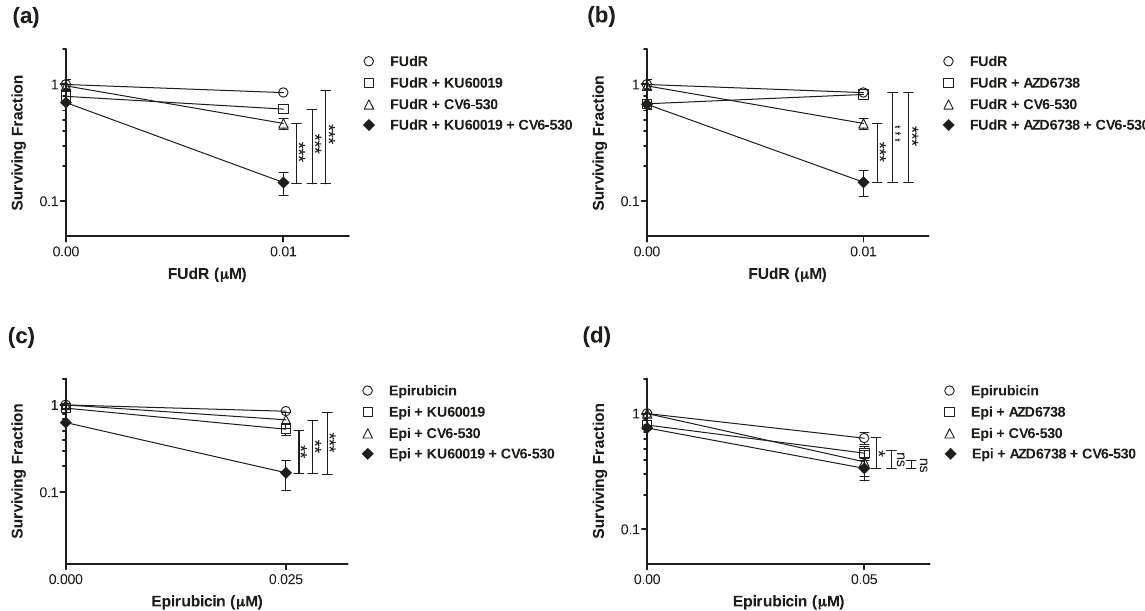
Fig. 4 Inhibition of dUTPase leads to replication stress and persistent DNA double-strand breaks following combination treatment with chemotherapy. Cell survival was determined by colony formation assay. MDA-MB-231 cells were seeded into 24-well plates and treated with ( a , b ) 0.01 µM FUdR alone or in combination with 12.5 µM CV6-530 and/or ( a ) 2.5 µM ATM inhibitor (KU-60019) or ( b ) 100 nM ATR inhibitor (AZD6738) or ( c , d ) 0.025 or 0.05 µM epirubicin (4 h) alone or in combination with 12.5 µM CV6-530 (24 h) and/or ( c ) 2.5 µM ATM inhibitor (KU-60019, 24 h) or ( d ) 100 nM ATR inhibitor (AZD6738, 24 h). Drug-containing media was then replaced with drug-free media for 12 – 15 days and cells were allowed to form colonies (>50 cells). All data points are expressed as mean ± SEM ( N = 3, independent experiments). ns, not signi fi cant; * P < 0.05; ** P < 0.01; *** P < 0.001 by an unpaired, two-tailed Student t